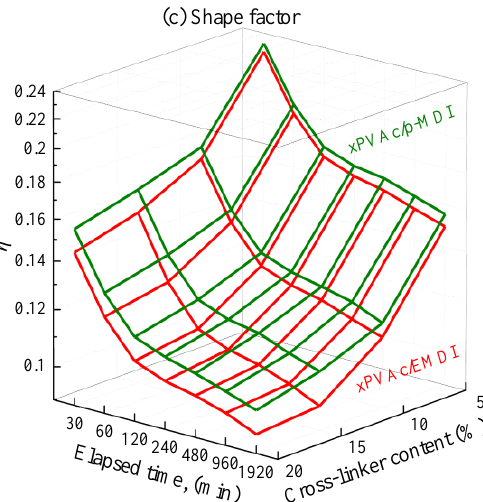
Figure 5. E ff ect of aging time on the KWW parameters for EPI with di ff erent crosslinkers. Figure 5. Effect of aging time on the KWW parameters for EPI with different crosslinkers. Note that the shape factor of creep curve would decrease as the amount of isocyanate